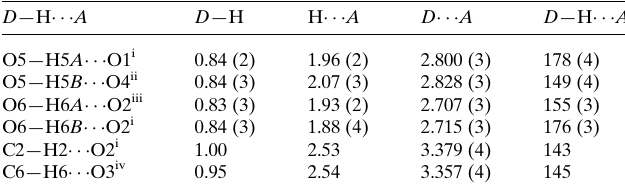
Table 1 Hydrogen-bond geometry (A˚ , (cid:5) ).